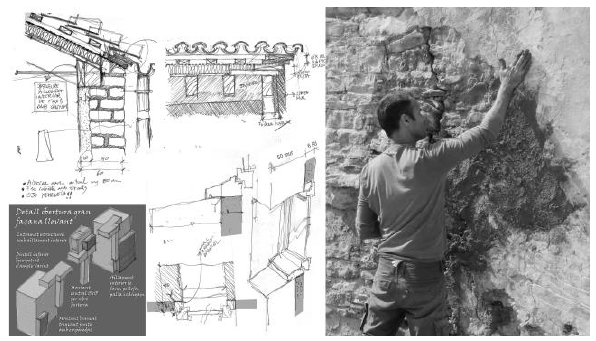
Figure 4. Design and applying process of the inside thermal layer.